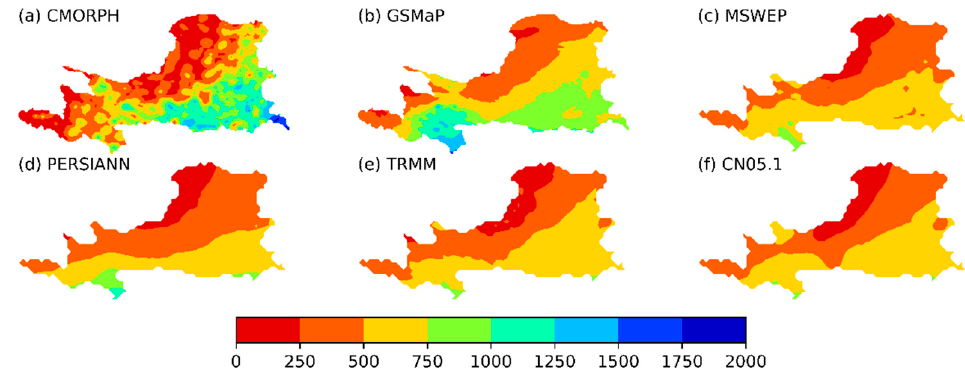
Figure 3. Spatial pattern of annual mean precipitation.